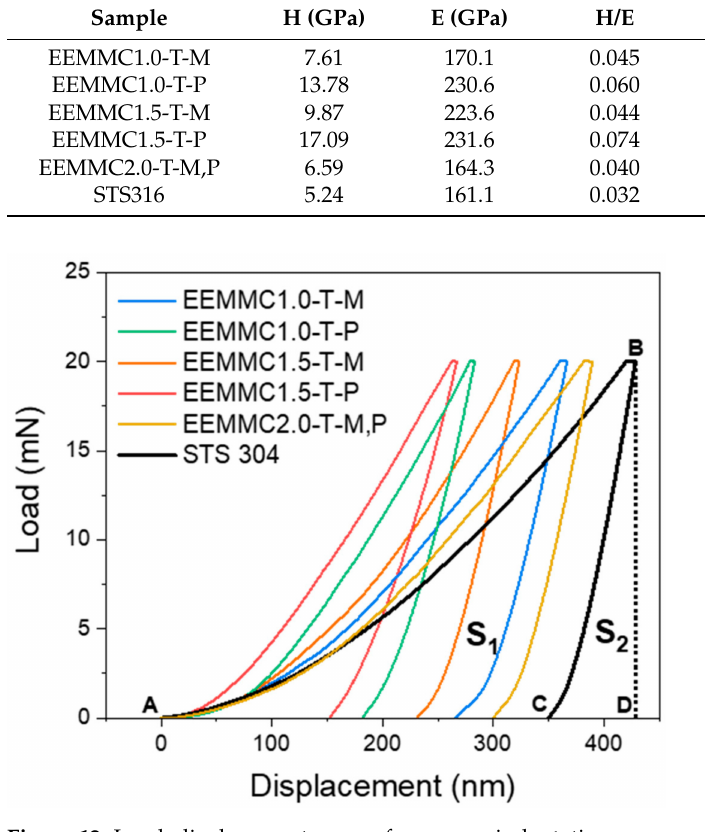
Figure 12. Load–displacement curves from